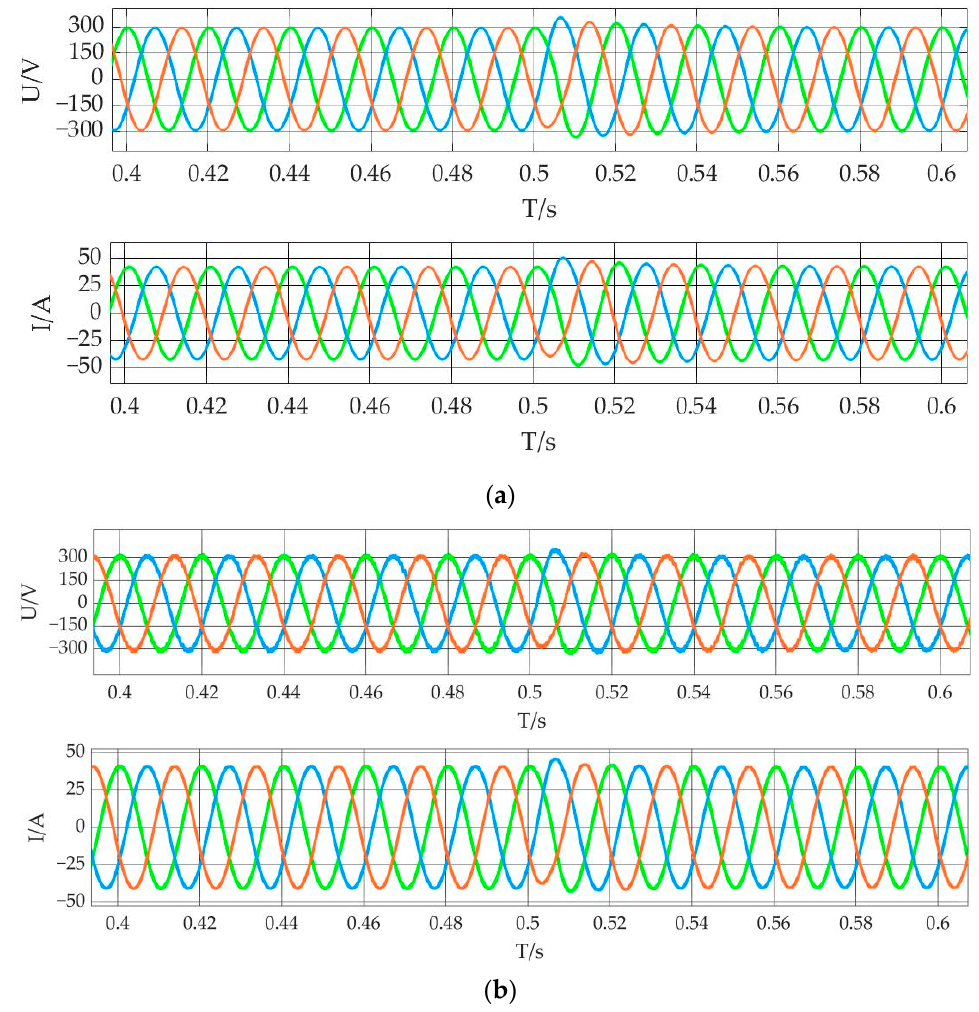
Figure 12. Voltage and current diagram of the second type of islanding critical load. ( a ) With v/F control. ( b ) With electric spring control.